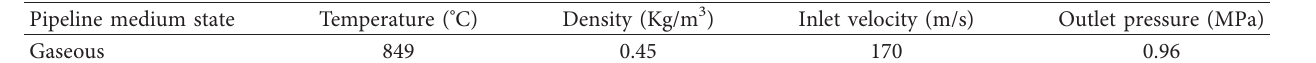
Table 2: Boundary conditions.